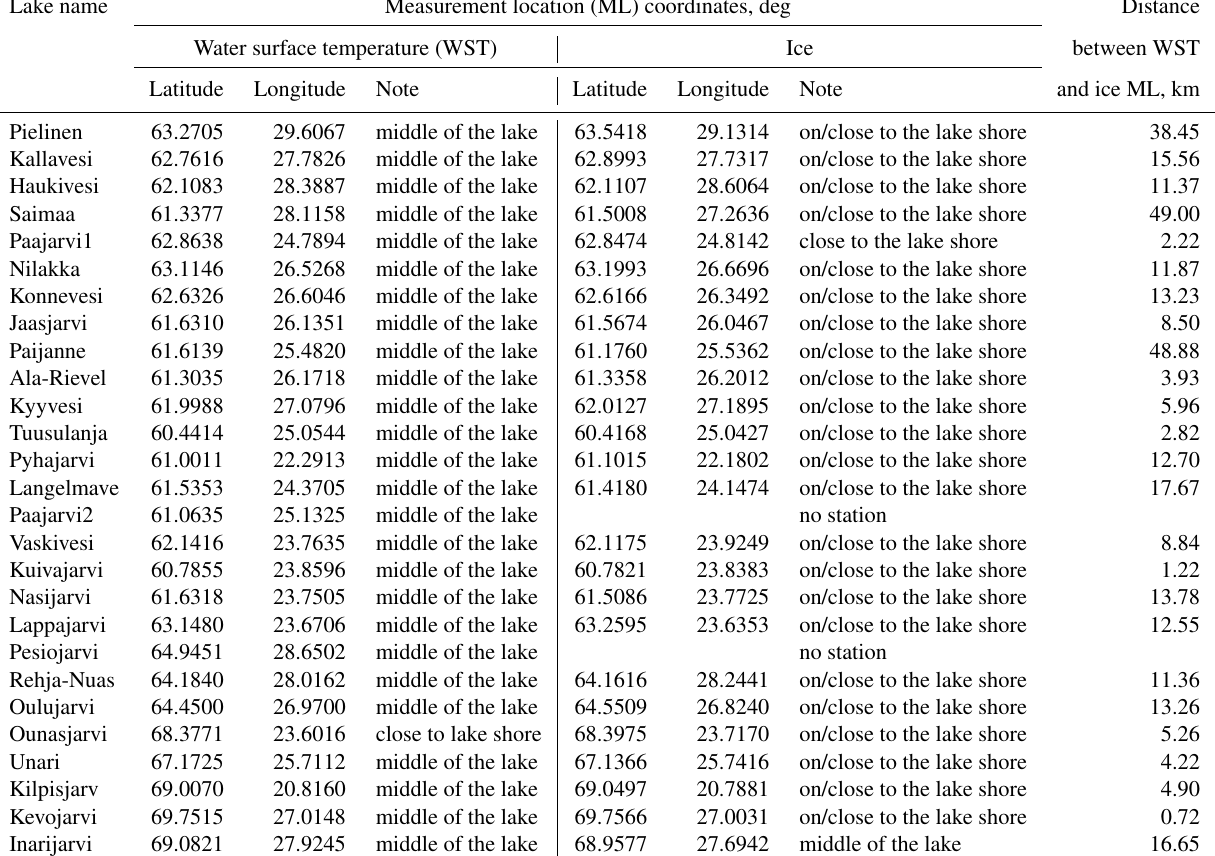
Table 5. Locations of in situ water surface temperature and ice formation/disappearance measurement points and distance between them for 27 verification sites; latitude and longitude in degrees, distance in